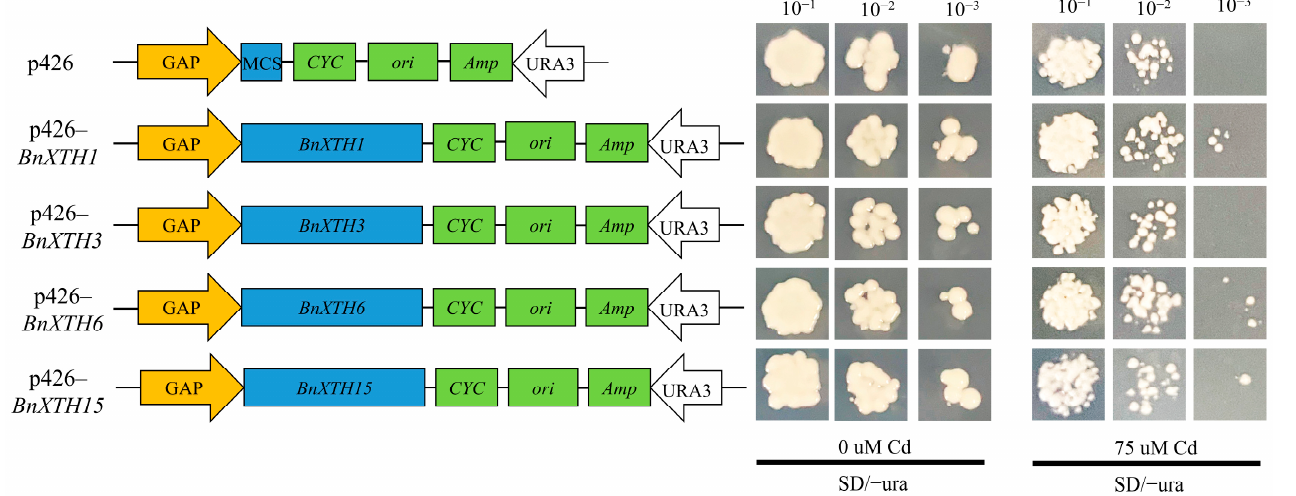
Figure 7. Functional analysis of BnXTH genes through heterologous expression in yeast. ( a ) Schematic diagram of the constructed yeast vector. p426 represents the empty vector, while p426– BnXTH1 , p426– BnXTH3 , p426– BnXTH6 , and p426– BnXTH15 represent the recombinant p426 vectors that contained the BnXTH1 , BnXTH3 , BnXTH6 , and BnXTH15 genes, respectively. ( b ) Cd-tolerance assay of BnXTH genes in transgenic yeast ( Δ yap1 ). The yeast cells were treated with 0 μ M and 75 μ M of Cd in an SD-URA medium for 3 days at 30 °C.